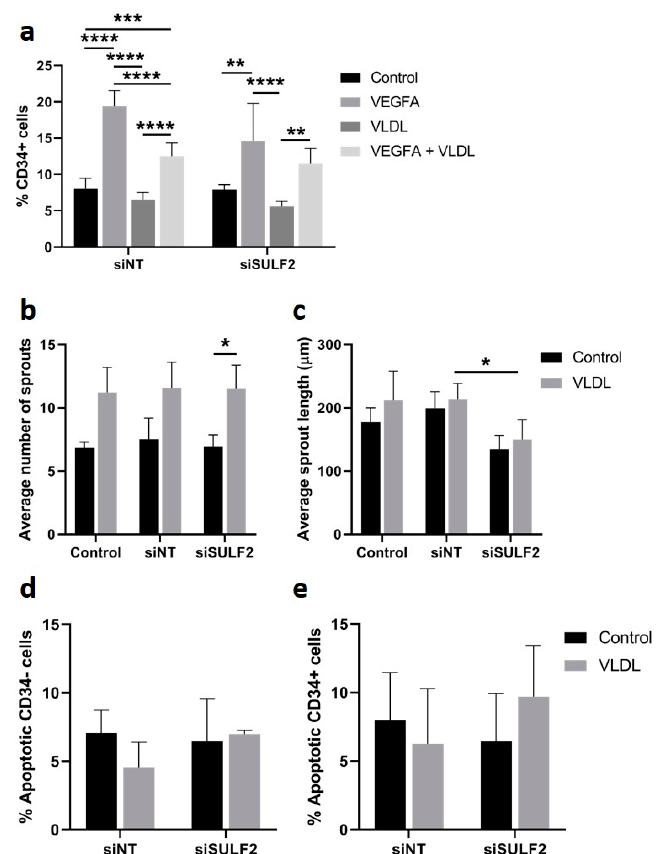
Figure 6. Effect of VLDL on tip cell formation, sprouting, and apoptosis. HUVECs were cultured in the presence or absence of VEGFA 165 and/or VLDL or after treatment with siNT or si SULF2 . ( a ) Flow cytometric analysis of CD34 + cells (% of total number of cells). Average number ( b ) and length in µ m ( c ) of sprouts per HUVEC spheroid. Relative amount of apoptotic CD34 - ( d ) and CD34 + cells ( e ). Results are presented as the mean ± standard deviation of three HUVEC donors. Two-way ANOVA was used to calculate statistical differences (* p < 0.05, ** p < 0.01, *** p < 0.001, **** p < 0.0001).